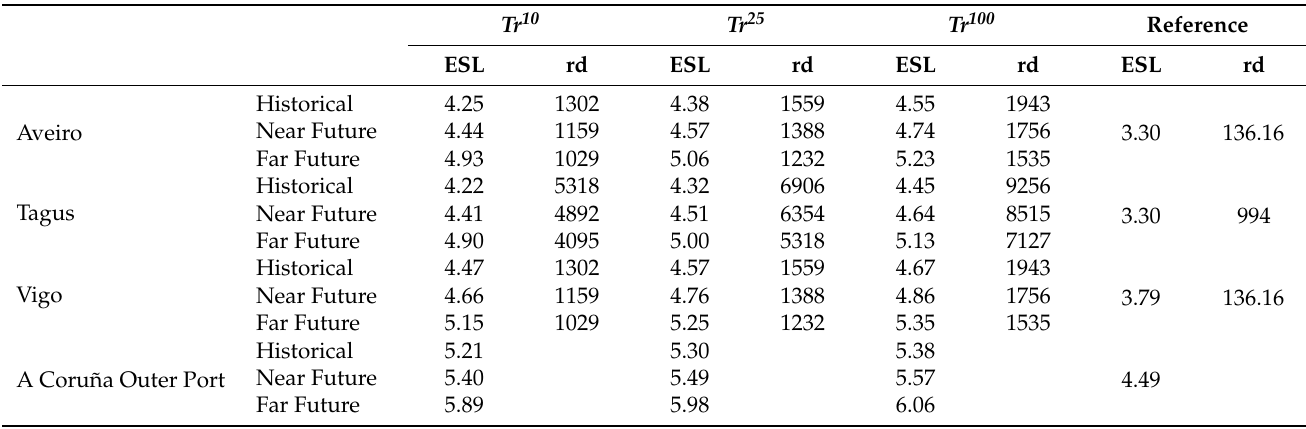
Table 6. Scenario definition: extreme sea levels (ESL in meters, evaluated in Section 3.2) for the 10-, 25- and 100-year return periods ( Tr ) for the reference scenario (referred to present climate), and the